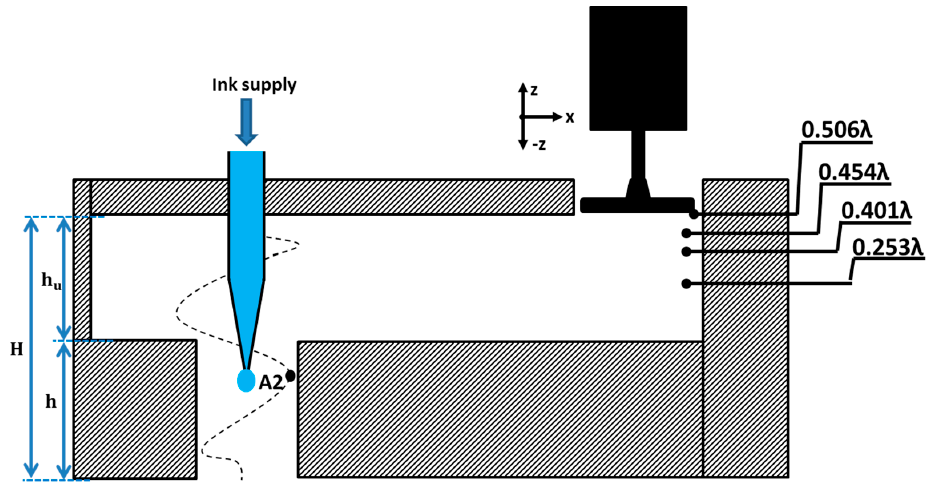
Figure 2. Schematic cross–sectional representation of SWAM with nozzle and standing wave at acoustic cavity of height H and standing wave-source chamber showing four different positions at which the SWGP is